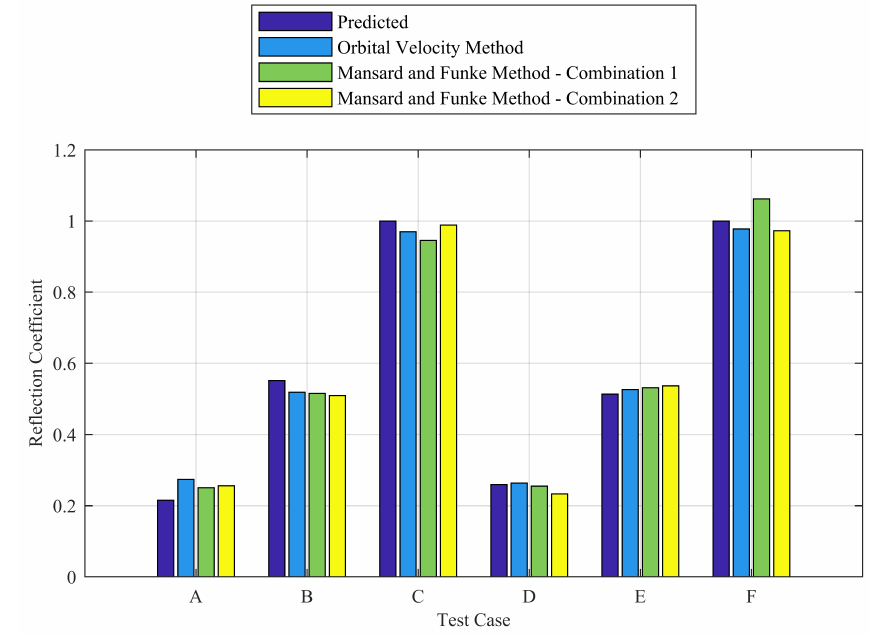
Figure 6. Graphical representation of Tables 5 and 6. Table 5. Reflection coefficients using different methods from the deep water (1.0m) simulations.